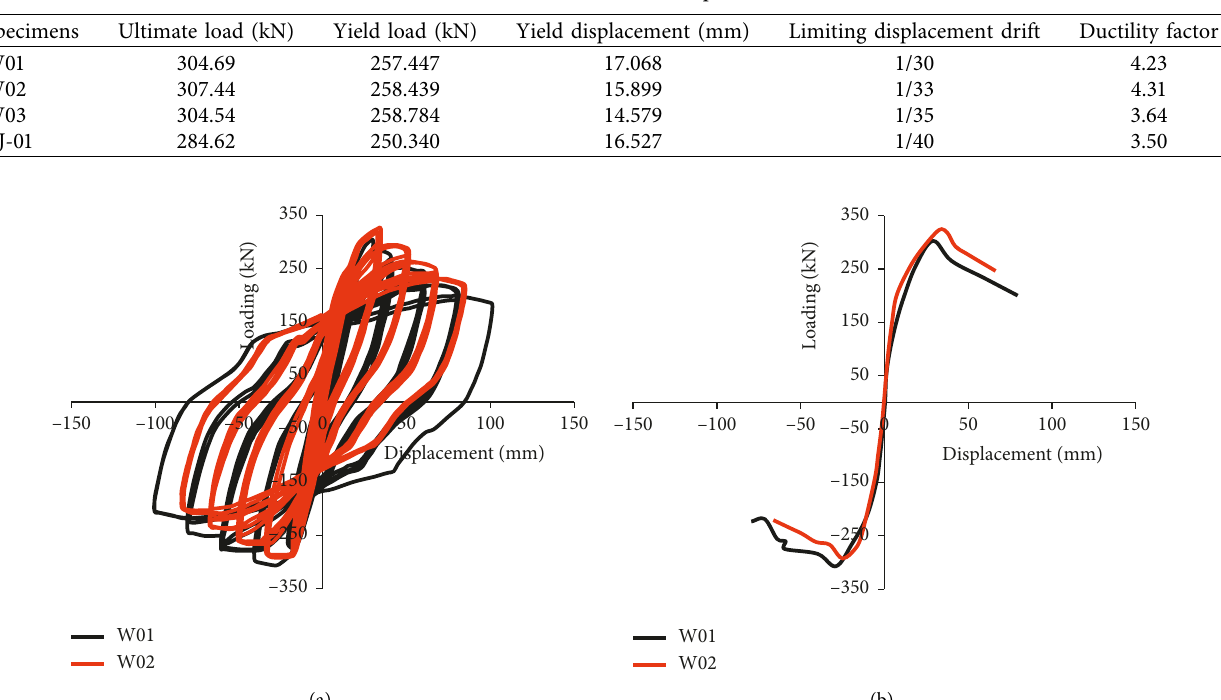
Figure 6: Skeleton curves of the specimens. (a) W01. (b) W02. (c) W03. (d) XJ-01. Table 4: Seismic indicators of